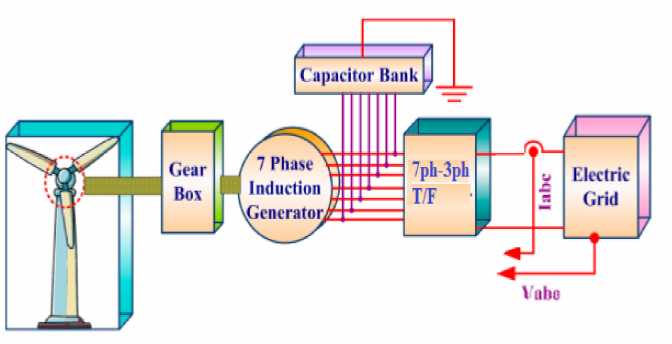
Figure 11. Schematic block diagram of a wind energy conversion system (WECS)-based multi- phase